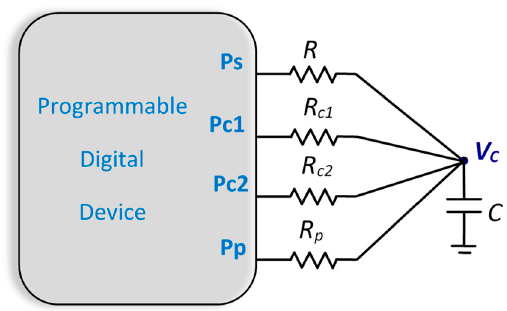
Figure 1. Circuit used in the two-point calibration method (TPCM).